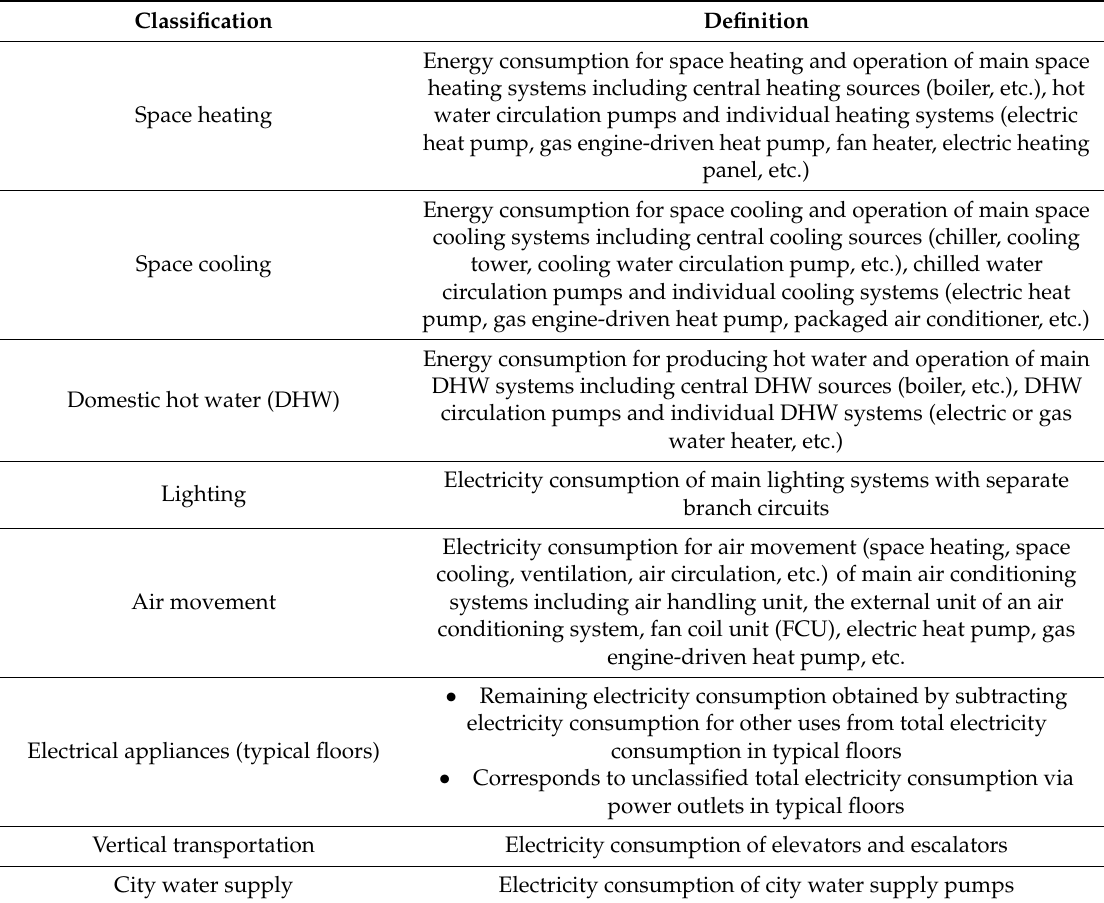
Table 3. Classifications and definitions of energy consumption by end-use in o ffi ce